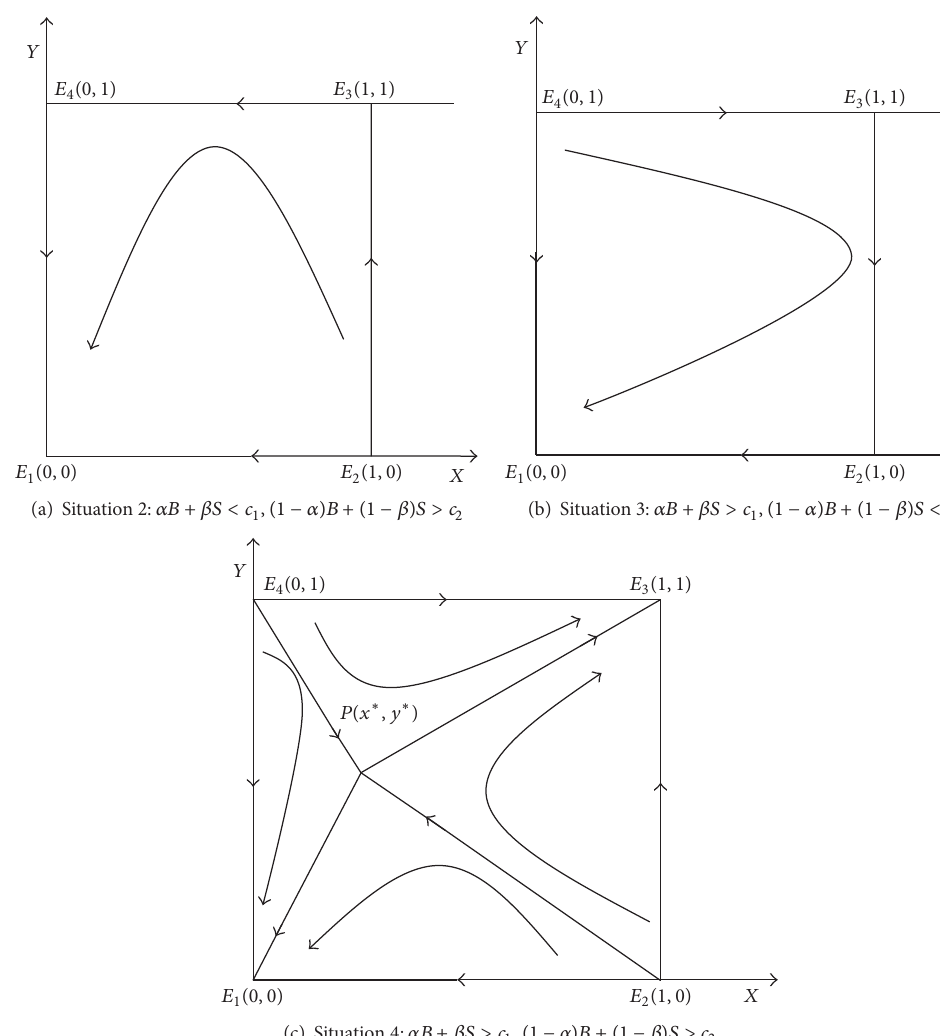
Figure 3: The phase diagrams of the other three